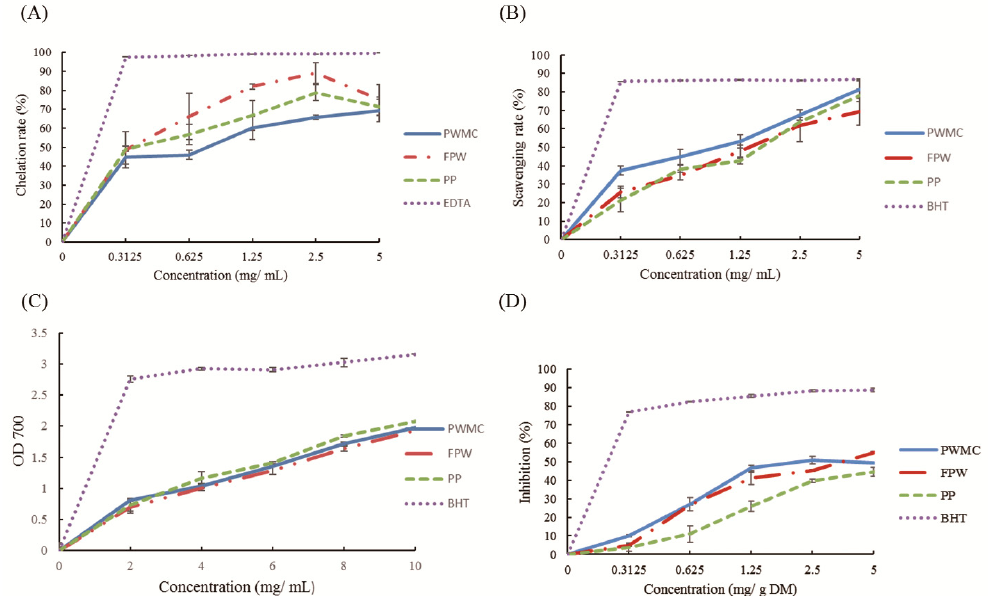
Figure 1. Antioxidant capacity analysis in Pennisetum purpureum Schum No.2 waste mushroom compose (PWMC), Saccharomyces cerevisiae fermented PWMC (FPW), and Pennisetum purpureum Schum No.2 (PP). ( A ) Ferrous ion chelation rate; ( B ) Di (phenyl)-(2,4,6-trinitrophenyl) iminoazanium (DPPH) scavenging capacities; ( C ) Total reducing capacities under 700 nanometer absorbance; ( D ) Malondialdehyde production inhibition rate measured by 2-thiobarbituric acid reacting substances test (TBARS). Results are means of five samples from each analysis. n = 3.